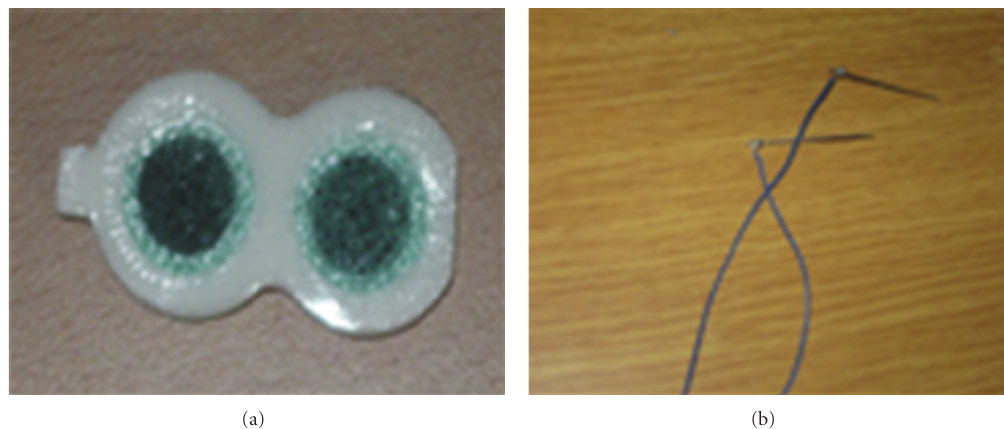
Figure 3: (a) Uni-Patch Tyco EMG electrodes (b) needle-type conductive electrodes.